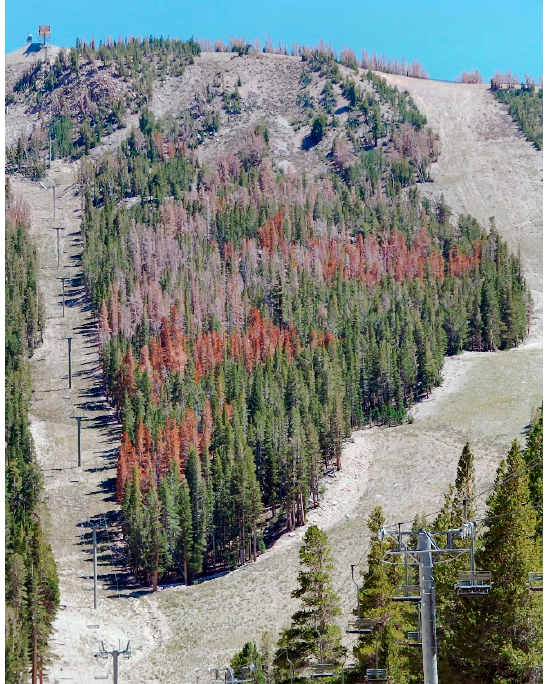
Figure 4. The June Mt. Ski Area case study site. Red-needled lodgepole pines were attacked by mountain pine beetles following the initial attack on whitebark pine at higher elevations.